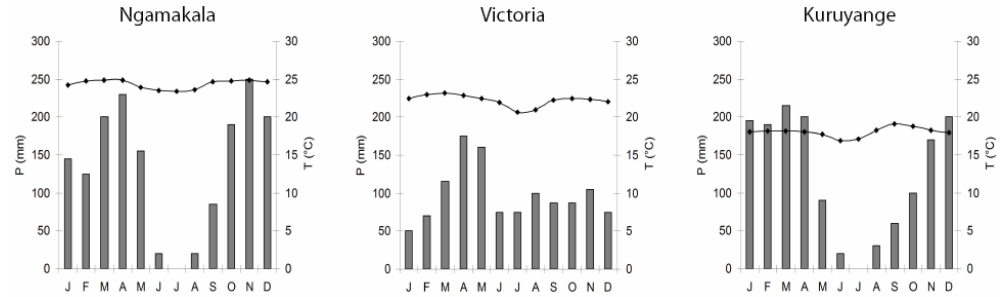
Fig. 2. Current mean monthly temperatures (lines) and precipitation (bars) distribution for the three studied sites (Leemans and Cramer,